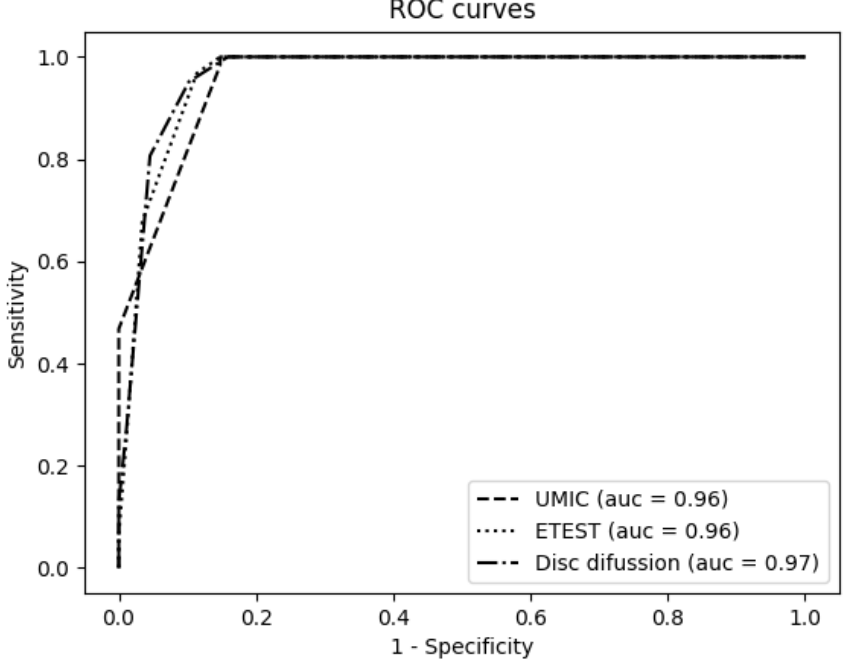
Figure 2. Correlation of each testing method versus the reference (BMD) represented by regression curves and R-squared.